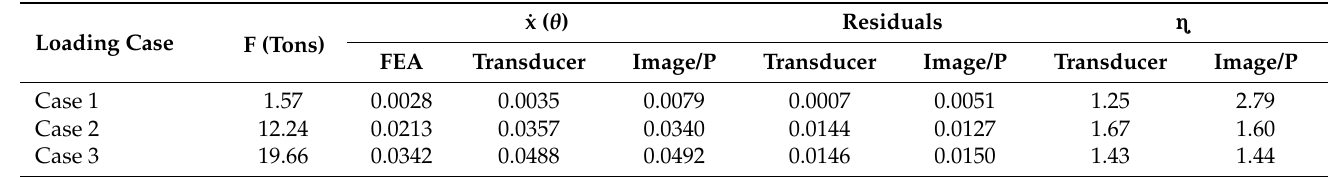
Table 3. Residuals and Validation